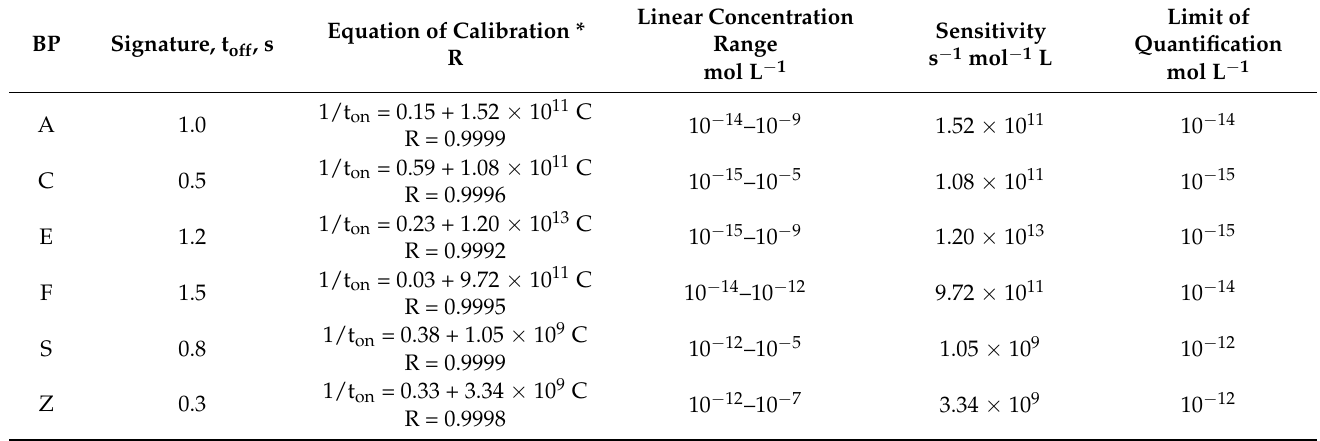
Table 1. Response characteristics of the 2D disposable sensors used for the assay of BPA, BPC, BPE, BPF, BPS, and BPZ.